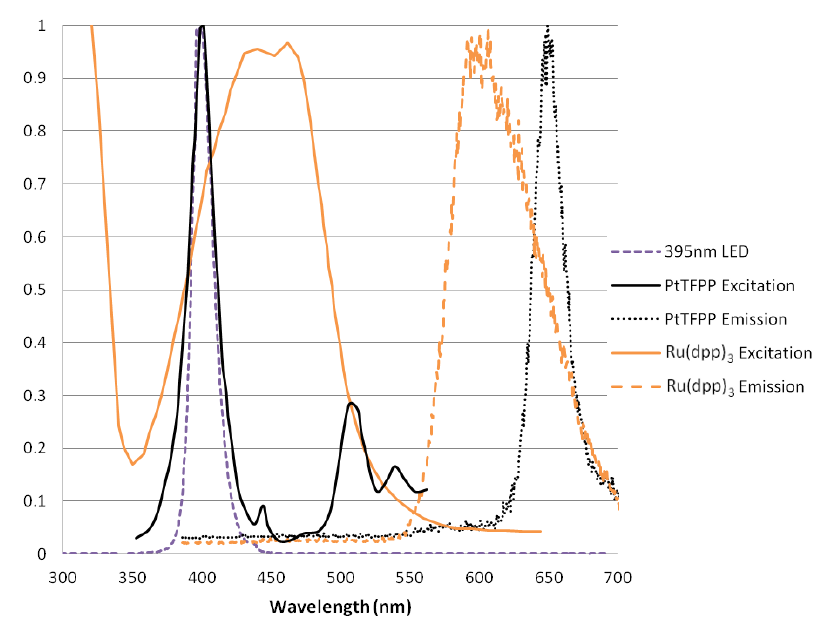
Figure 3. Illumination Source and PSP